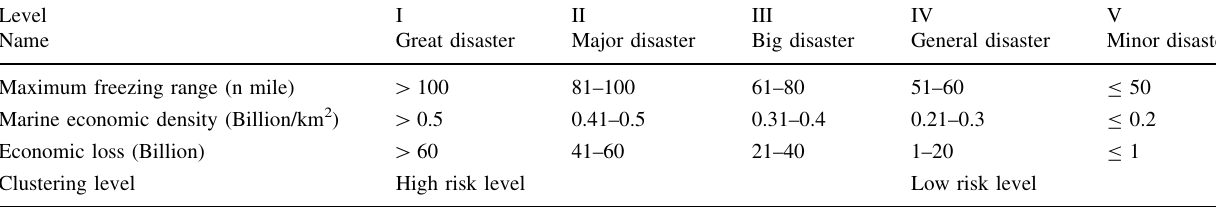
Table 6 Level criteria needed to determine sea ice disaster states ( Source State Oceanic Administration 2010)